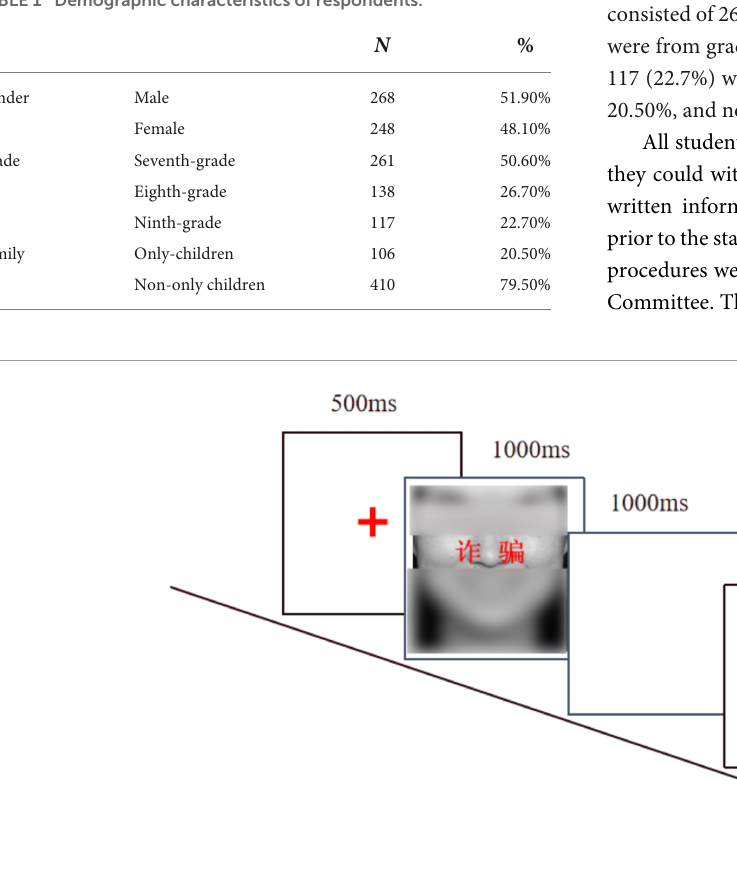
school to complete the remaining 3 years of compulsory education. At the stage of middle school, the average age of adolescents is about 12–15 years old, and they are allowed to go home every 2 weeks due to the impact of the epidemic. A total of